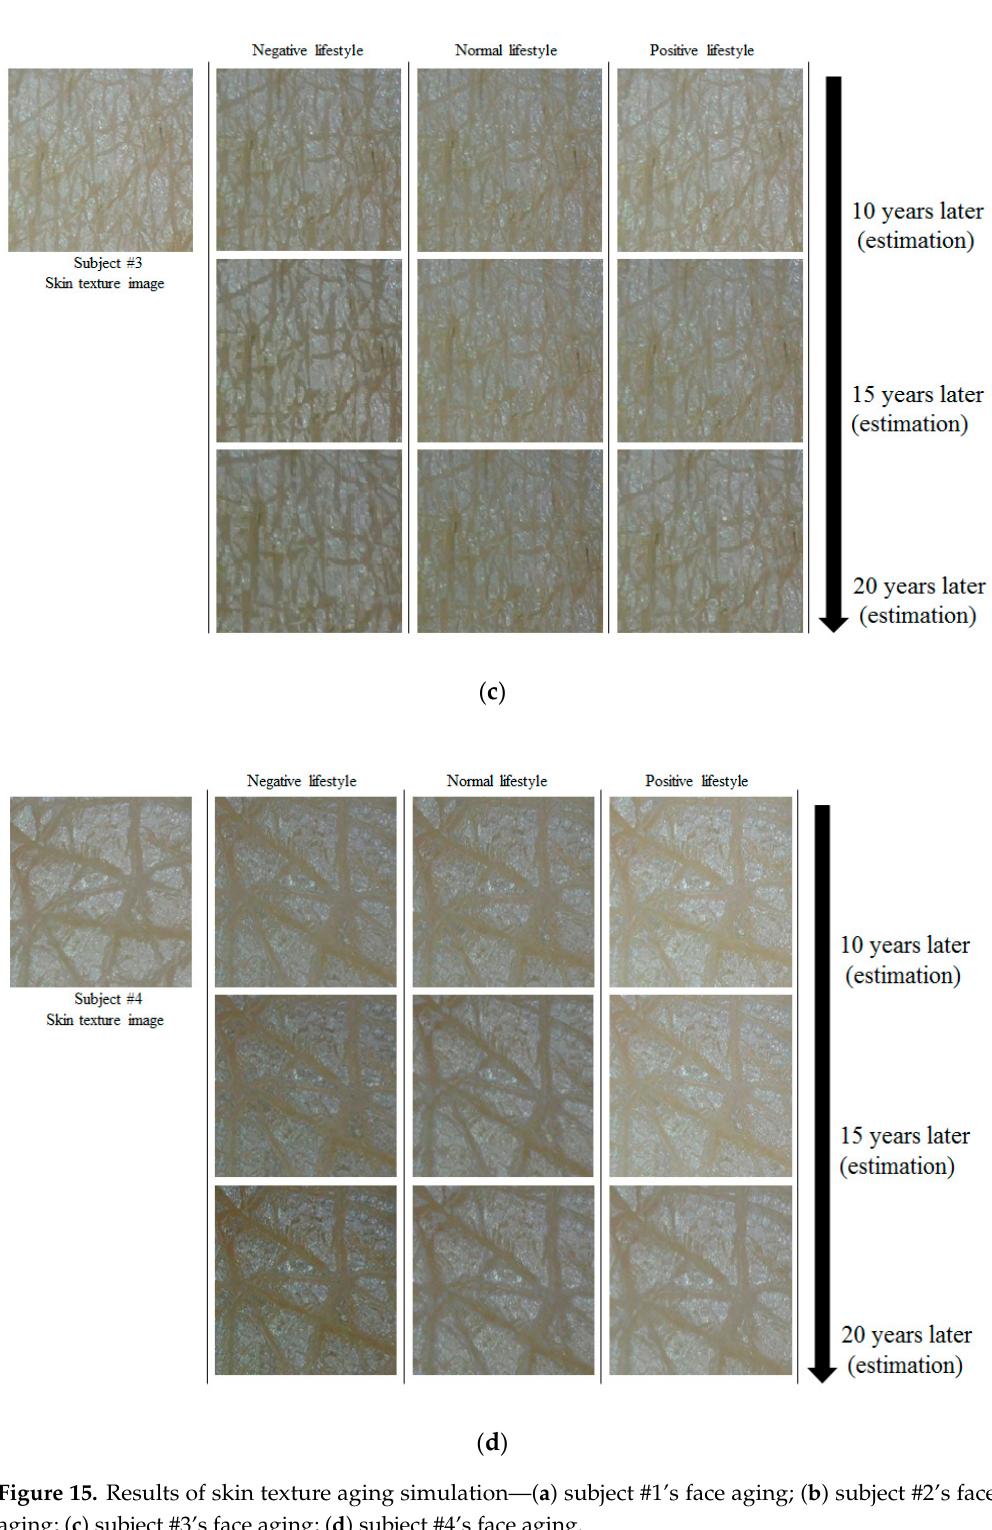
Figure 15. Results of skin texture aging simulation—( a ) subject #1’s face aging; ( b ) subject #2’s face aging; ( c ) subject #3’s face aging; ( d ) subject #4’s face aging.